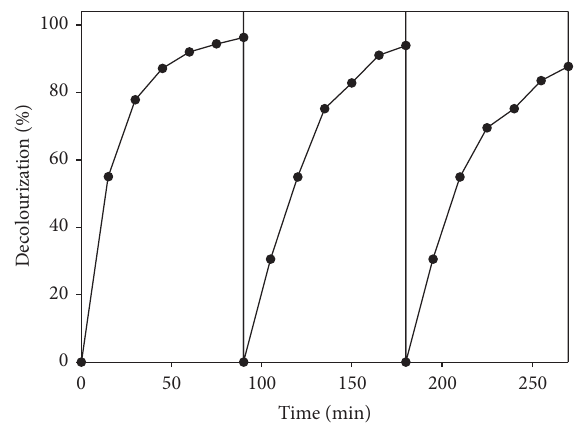
Figure 5: Decolourization profile of Reactive Black 5 using the electro-Fenton treatment in successive cycles.